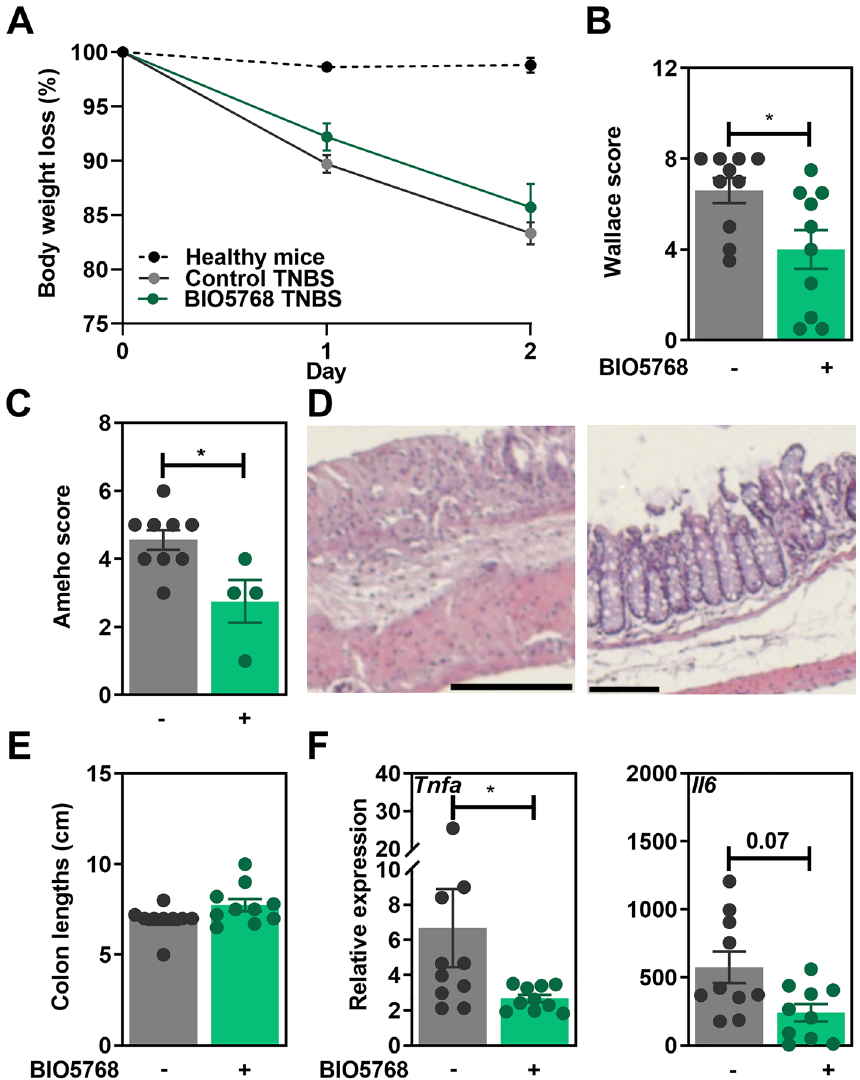
Figure 5. Protective effect of L. acidophilus BIO5768 supplementation in a mouse model of TNBS-induced colitis . BIO5768 (5 × 10 8 CFU of each) was administered to BALB/c mice for 5 consecutive days before and 1 day after TNBS induction (n = 10 mice per group). After 48 h, mice were sacrificed and the impact of BIO5768 was analyzed on ( A ) Body weight loss, ( B ) Macroscopic grading of inflammation according to Wallace score, ( C ) Histological analyses of colon tissue according to Ameho score. ( D ) Representative histological sections ( E ) Colon lengths. ( F ) Gene expression of pro-inflammatory markers as determined by qRT-PCR analysis. Results are expressed as relative gene expressions (2 −∆∆ct ) values, by comparing the PCR cycle thresholds (Ct) for the gene of interest and for the house keeping gene β-actin ( bact ), compared with control mice. Results correspond to means ± SEM of 10 mice per group of a representative experiment from 2 experiments. *p <